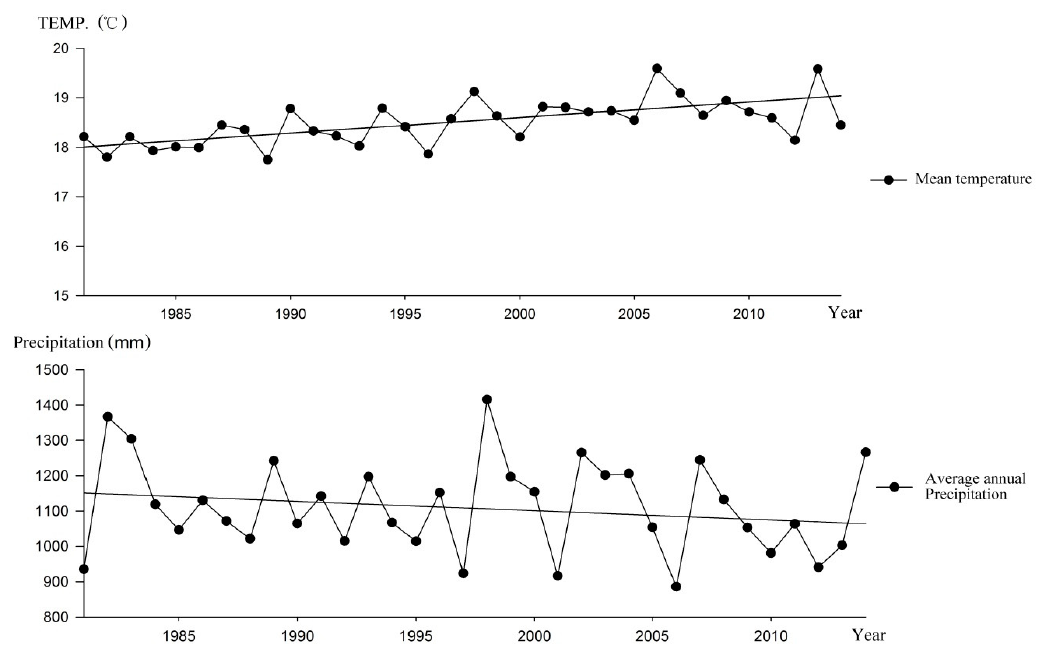
Figure 6. Interannual variation of annual precipitation in Three Gorges Reservoir Area in 1981–2014.